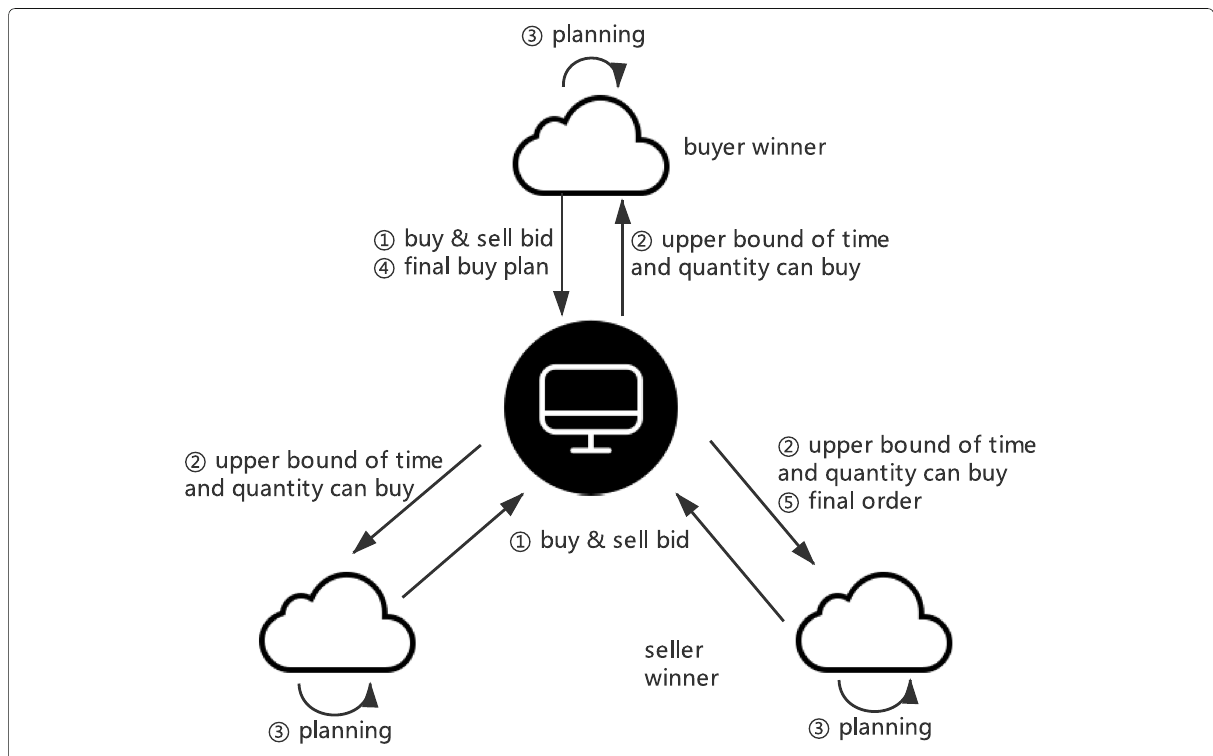
Fig. 2 Overview of the double auction